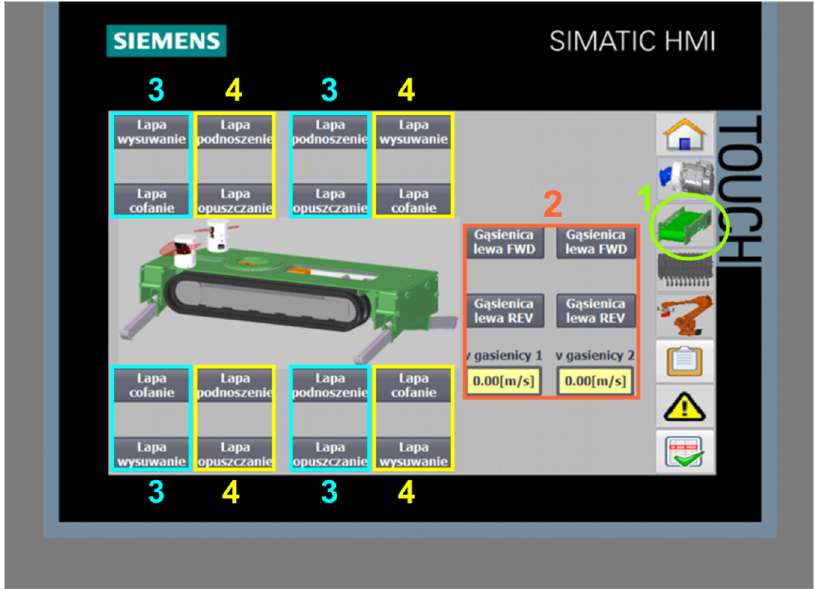
Figure 20. Touch screen to control the movement of the track undercarriage and the HLL module: 1: selected touch screen, 2: individual track drive select buttons, 3: extension and insertion of individual supporting legs, 4: lifting and lowering individual supporting legs.